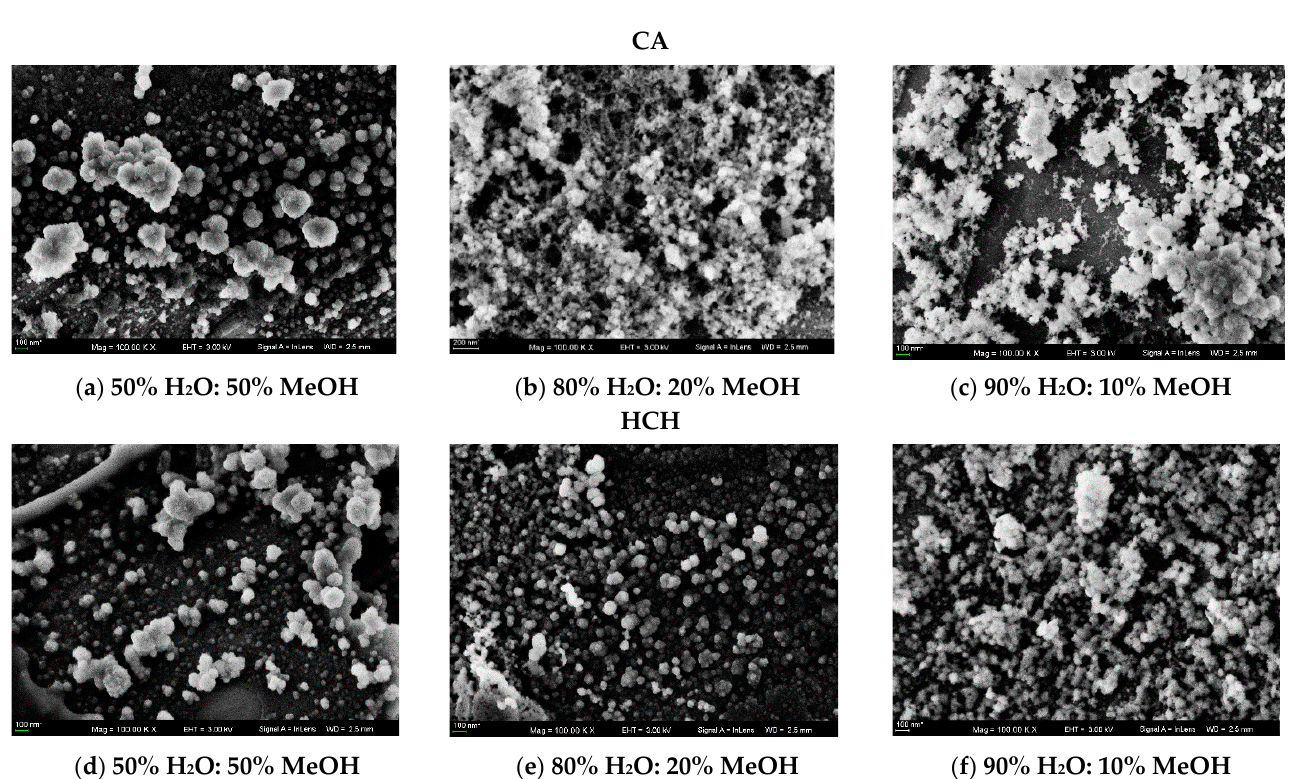
Figure 6. SEM images in the mixed solutions of CH 3 OH/H 2 O (5:5 v:v ) ( a ) CA and ( d ) HCH. SEM images in the mixed solutions of CH 3 OH/H 2 O (2:8 v:v ) ( b ) CA and ( e ) HCH. SEM images in the mixed solutions of CH 3 OH/H 2 O (1:9 v:v ) ( c ) CA and ( f ) HCH.